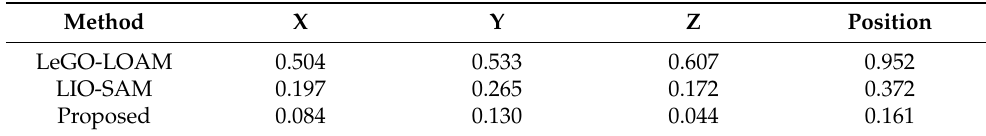
Table 3. The RMSE of absolute localization errors(m).